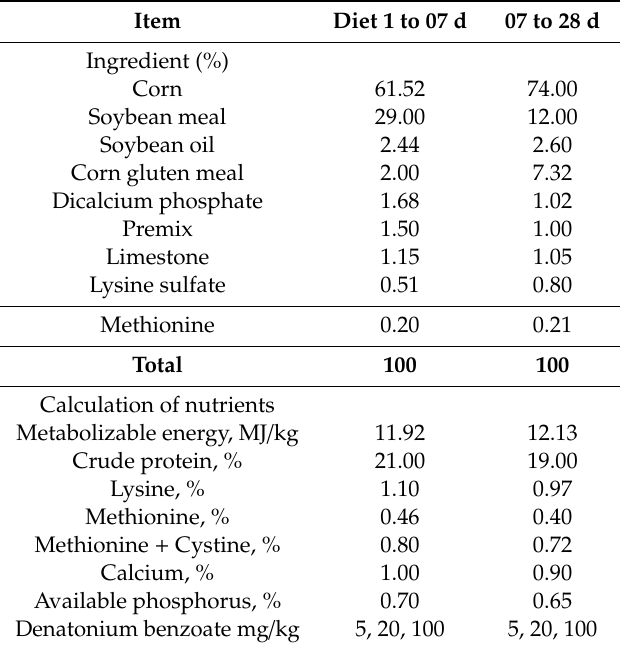
Table 1. Feed formulation for the entire period of experiment (d 1–d